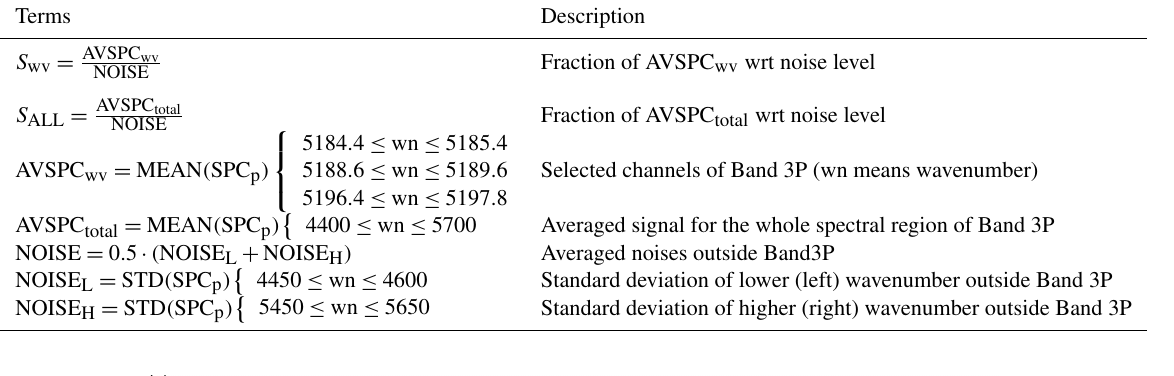
Table 1. Terms in the flowchart shown in Fig. 4.